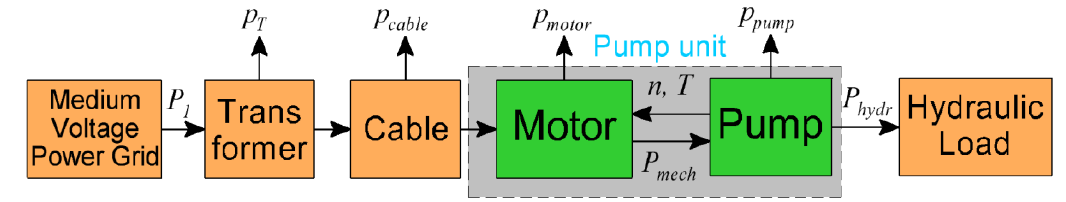
Figure 2. Diagram of a single pump unit for fixed-speed operation. Table 1. Published characteristics of pump from manufacturer.